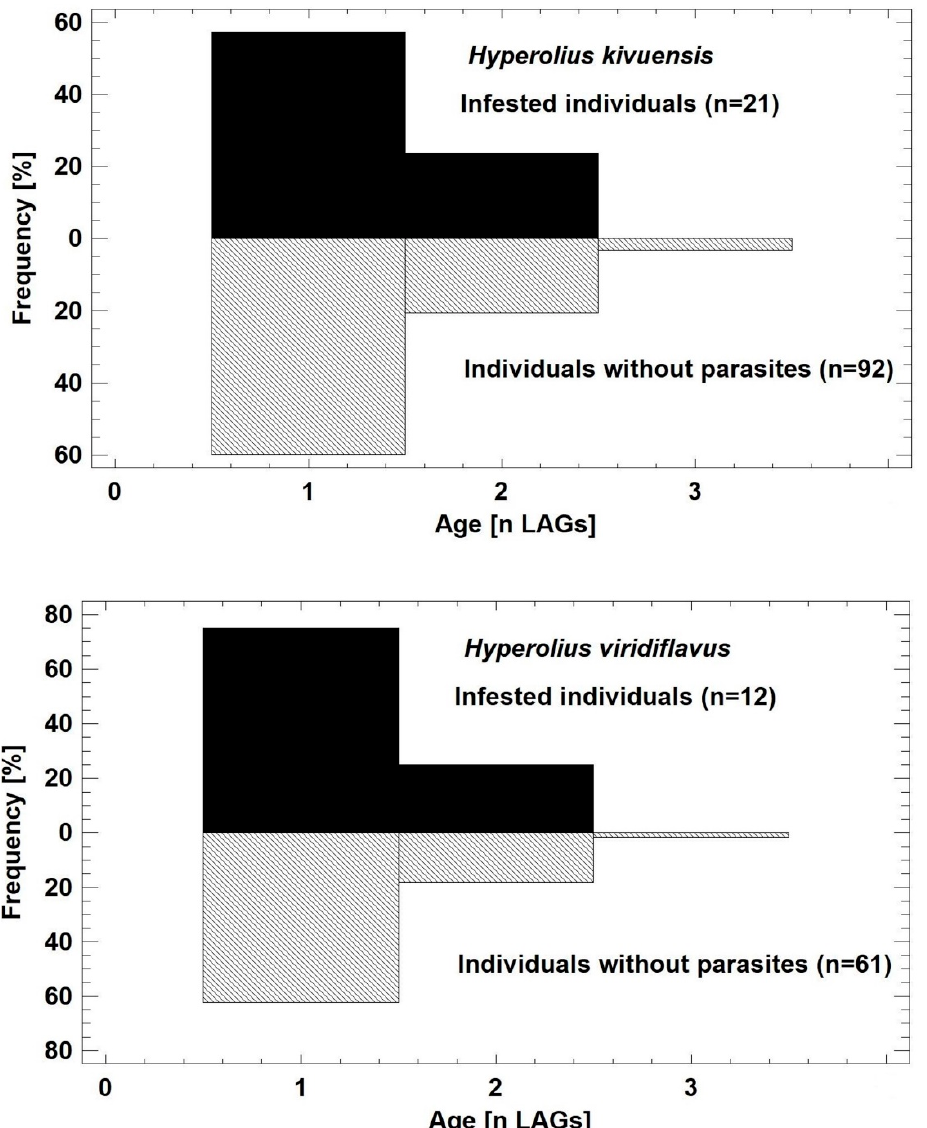
Figure 9. Age distribution of infested and metacercaria-free reed frogs H. kivuensis and H. viridiflavus . Details on statistical comparison are given in the text. Table 5. Sublethal impact of Clinostomum chabaudi metacercariae on size and femur features of reed frogs in Rwanda. Data are given as least square mean ± SE, calculated in an ANCOVA with infesta- tion state as fixed factor, and age and day within the rainy season as continuous covariables. Signif- icance of pairwise comparisons: ns = P > 0.05, * = P < 0.05, ** = P < 0.01, *** = P < 0.001.